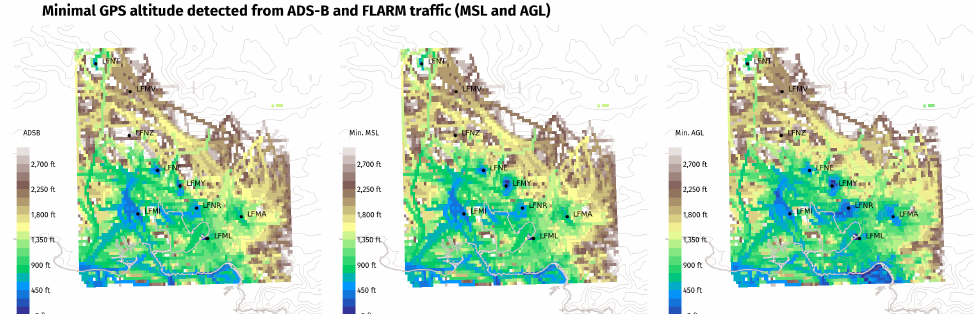
Figure 5. This minimal GPS altitude coverage map shows the importance of FLARM receivers when detecting traffic at VLL, especially near General Aviation airfields. VLL traffic (ambulance, firefighting) is also highlighted along the littoral, near downtown Marseille in the southeast.